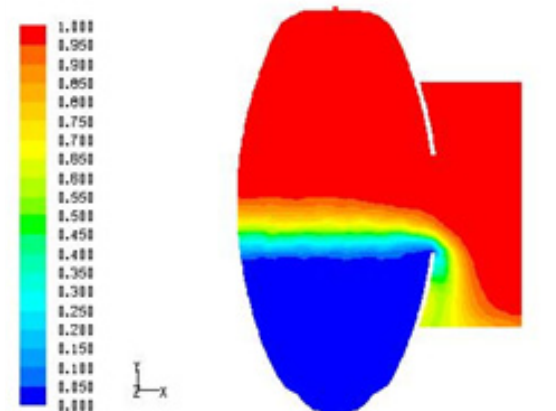
Fig. 3-1. At the lowest possible water level, the water hardly flows over the bottom edge of the outlet directly down on the bottom surface of the flange; the surrounding air is coming in from the right surroundings.